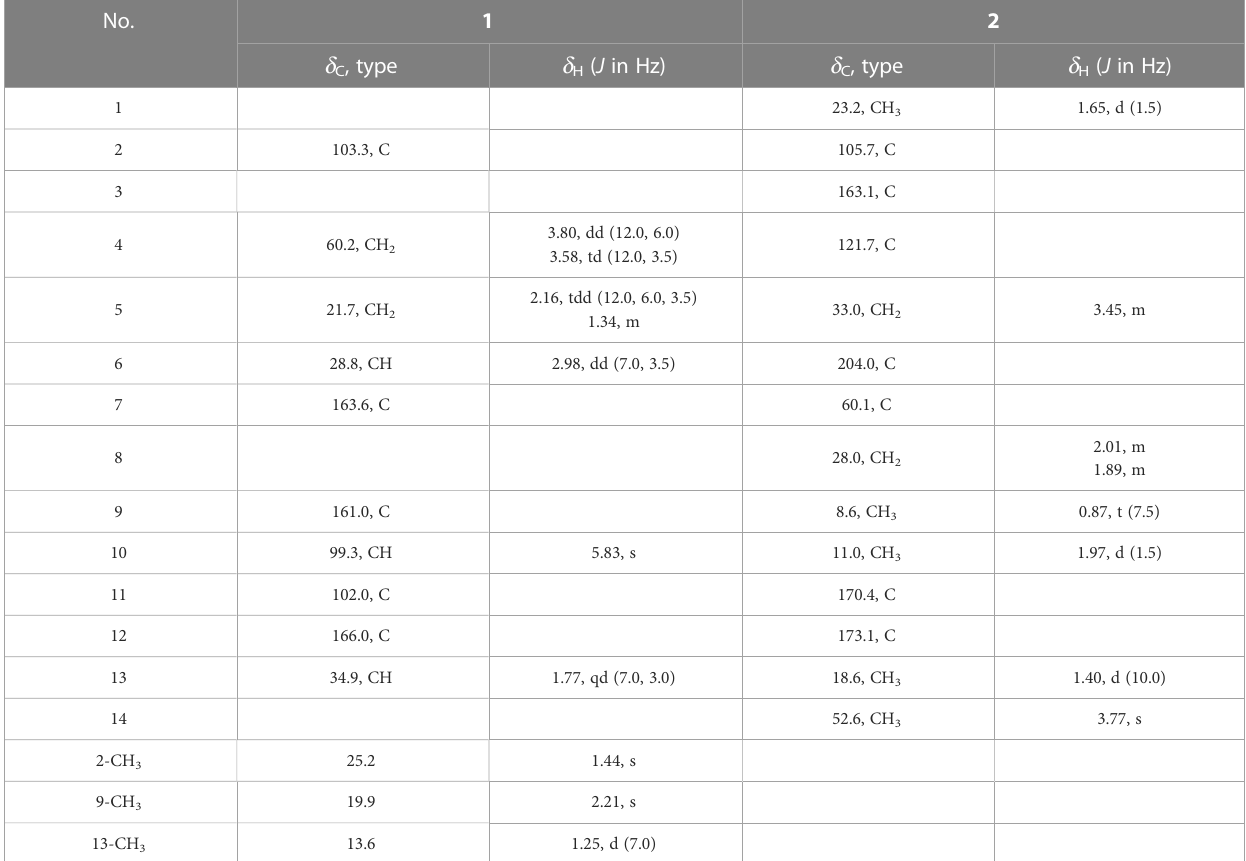
TABLE 1 1 H- (500 MHz) and 13 C-NMR (125 MHz) data for compounds 1 and 2 in CDCl 3 .